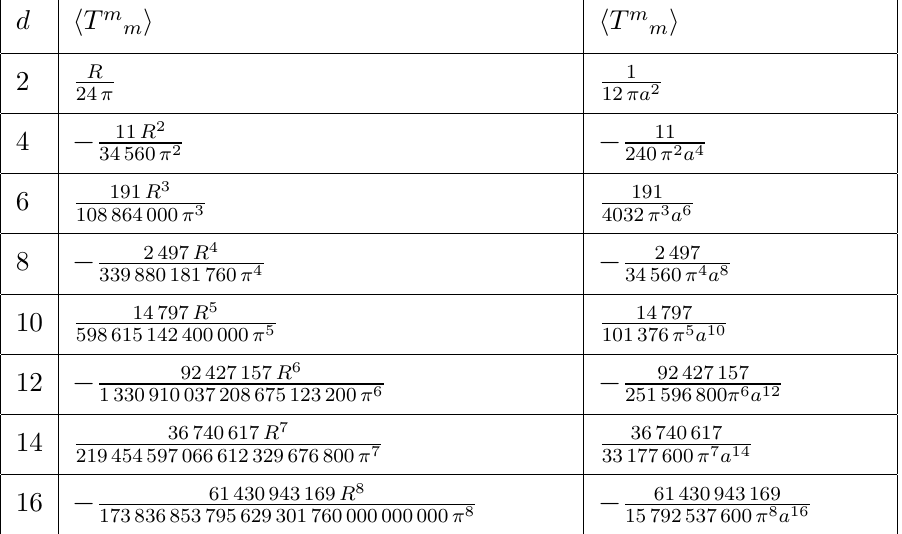
Table 1 . Type-A trace anomaly of a Dirac spinor in terms of the curvature scalar R , and in terms of the radius a , in various